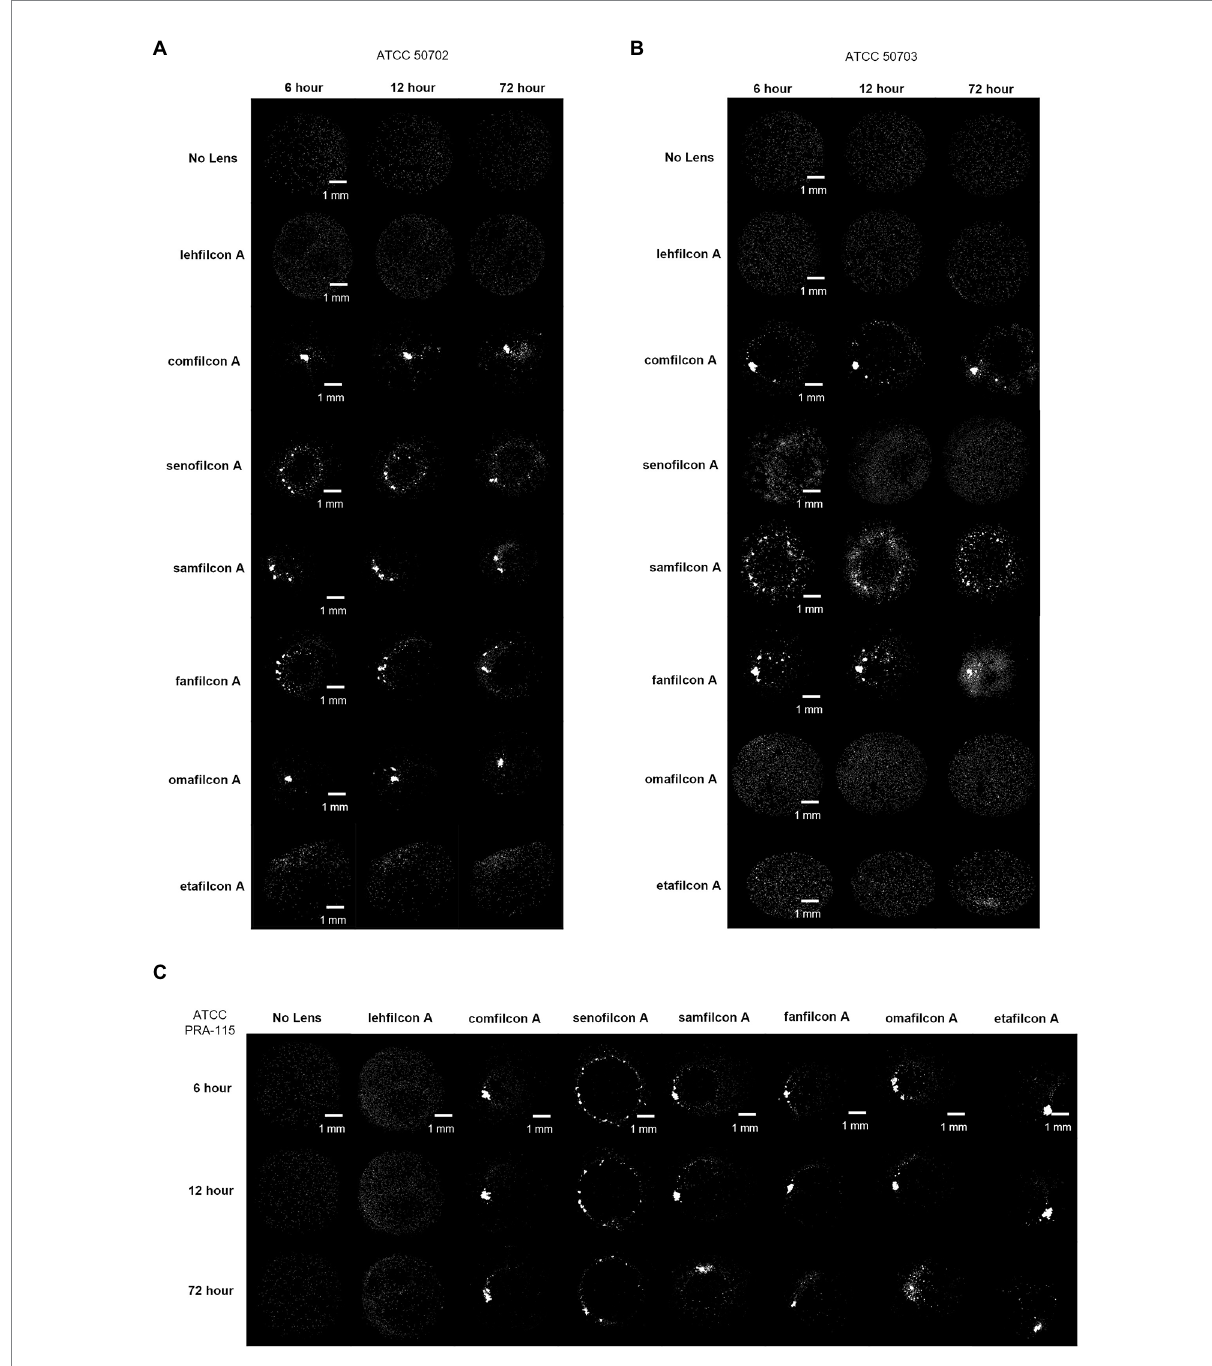
FIGURE 5 Representative images of Acanthamoeba on contact lens materials at 6, 12, and 72 h. (A) ATCC 50702, (B) ATCC 50703, (C) ATCC PRA-115. Mean ± SE representation in Figure 3. n = 6 per